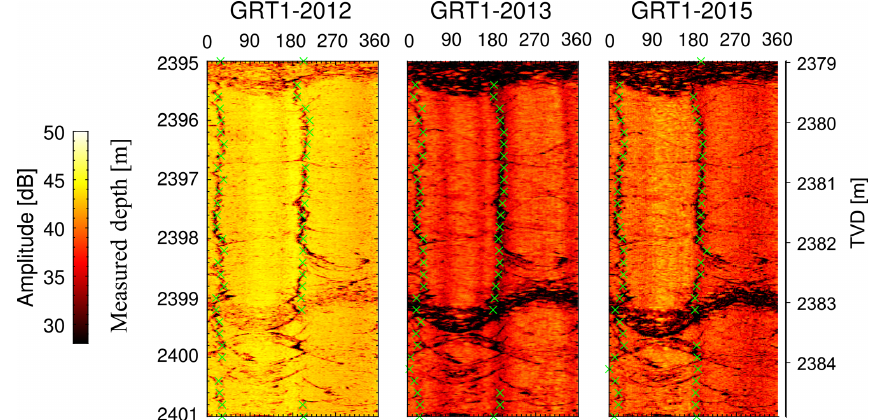
Figure 6. Examples of drilling-induced tension fractures (DITFs) observed in the granitic section of GRT-1 in the amplitude images acquired in 2012, 2013 and 2015. The azimuth of the DITFs is measured every 20cm (green crosses).